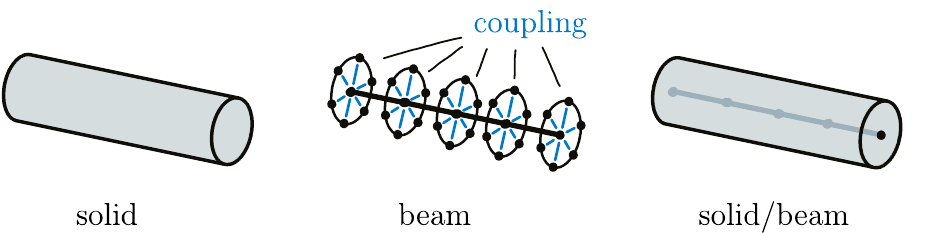
Figure 3. The three modeling approaches used for the cables: solid, beam, and a combination of both.